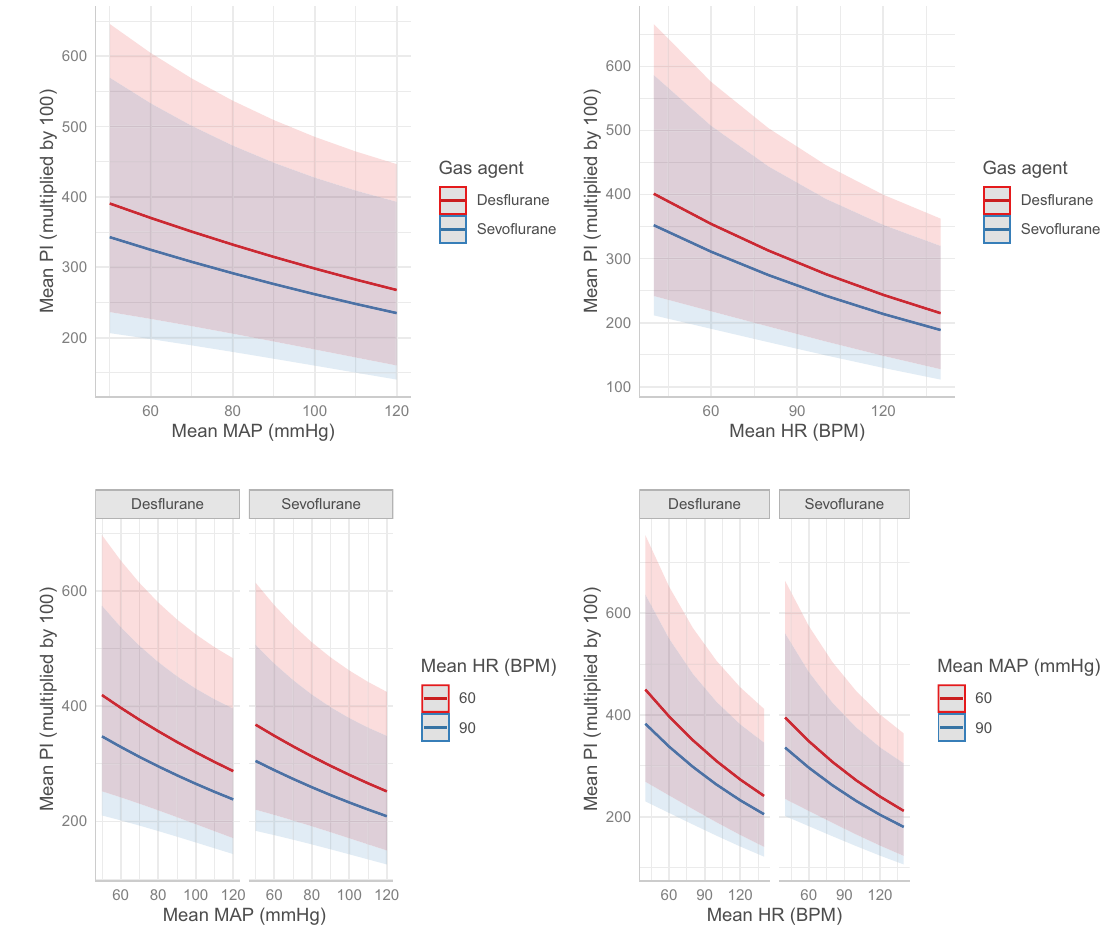
Figure 3. Effect of mean arterial pressure (MAP) and heart rate (HR) on perfusion index (PI) stratified by the type of inhalation agent. The plot presents the estimated marginal mean PI derived from the mixed-effects model. The shaded areas represent 95% confidence intervals of the estimated means. Note that the PI on the y-axis is multiplied by 100. BPM beat per